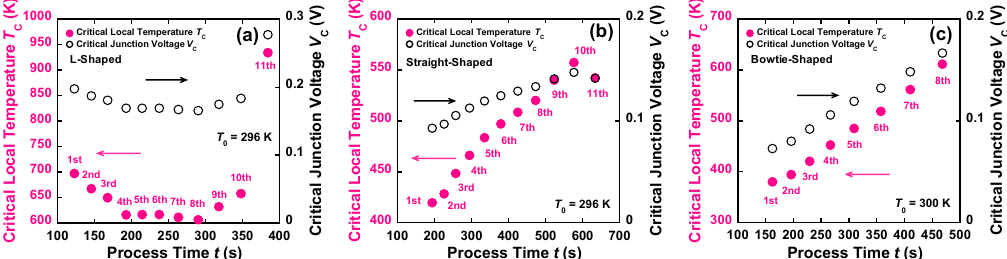
Figure 7. Time evolution of the T C – V C characteristics of the ( a ) L-shaped, ( b ) straight-shaped, and ( c ) bowtie-shaped nanowires as a function of the FCE process time. Table 2. Critical parameter ranges for the L-shaped, straight-shaped, and bowtie-shaped nanowires. Nanowire